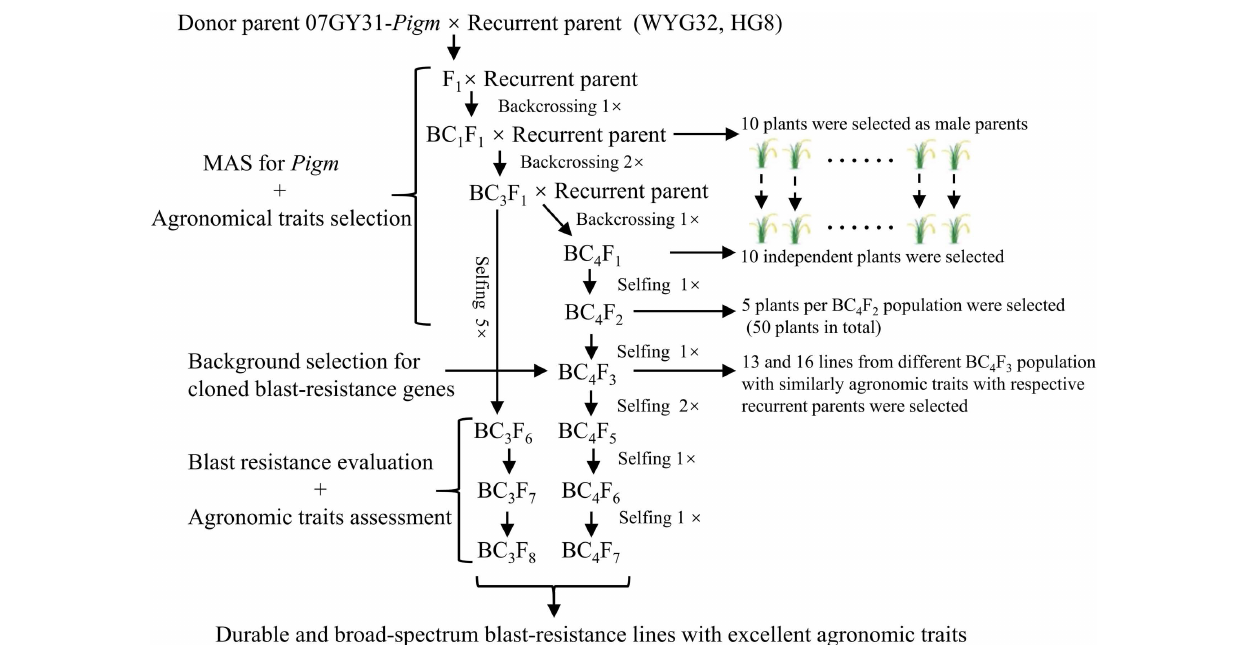
FIGURE 1 | Marker-assisted selection (MAS) scheme for transferring Pigm and developing durable and broad-spectrum blast-resistant lines. WYG32, Wuyungeng 32; HG8, Huageng 8.